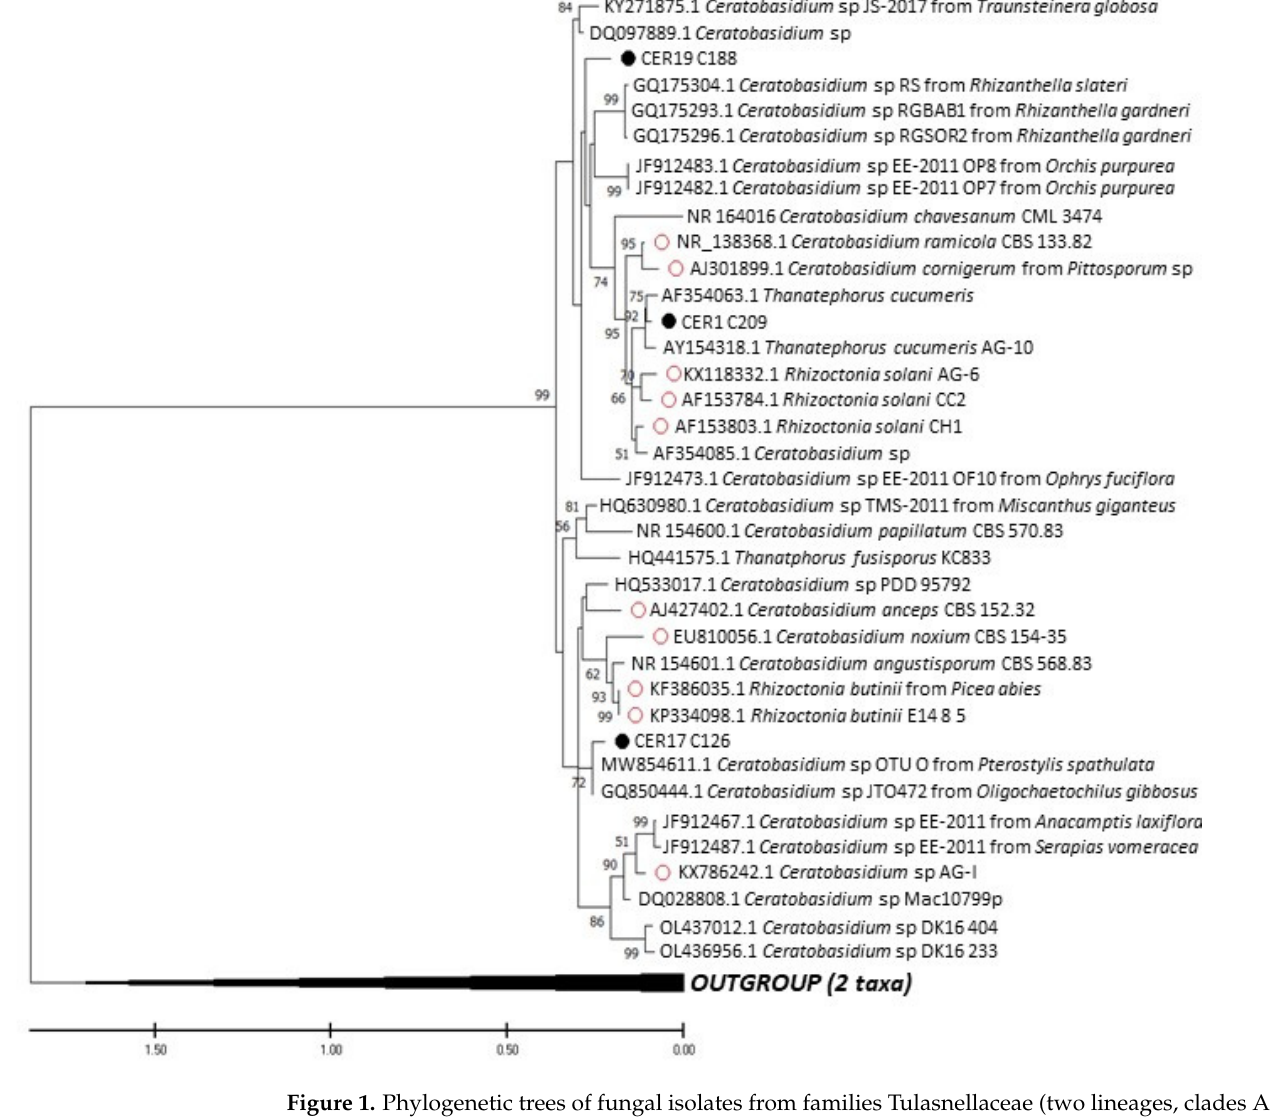
Figure 1. Phylogenetic trees of fungal isolates from families Tulasnellaceae (two lineages, clades A and B ( A ), Serendipitaceae ( B ), and Ceratobasidiaceae ( C ). The black circles represent the studied fungal isolates. The open red circles in the Ceratobasidiaceae tree represent fungal strains with reported pathogenic